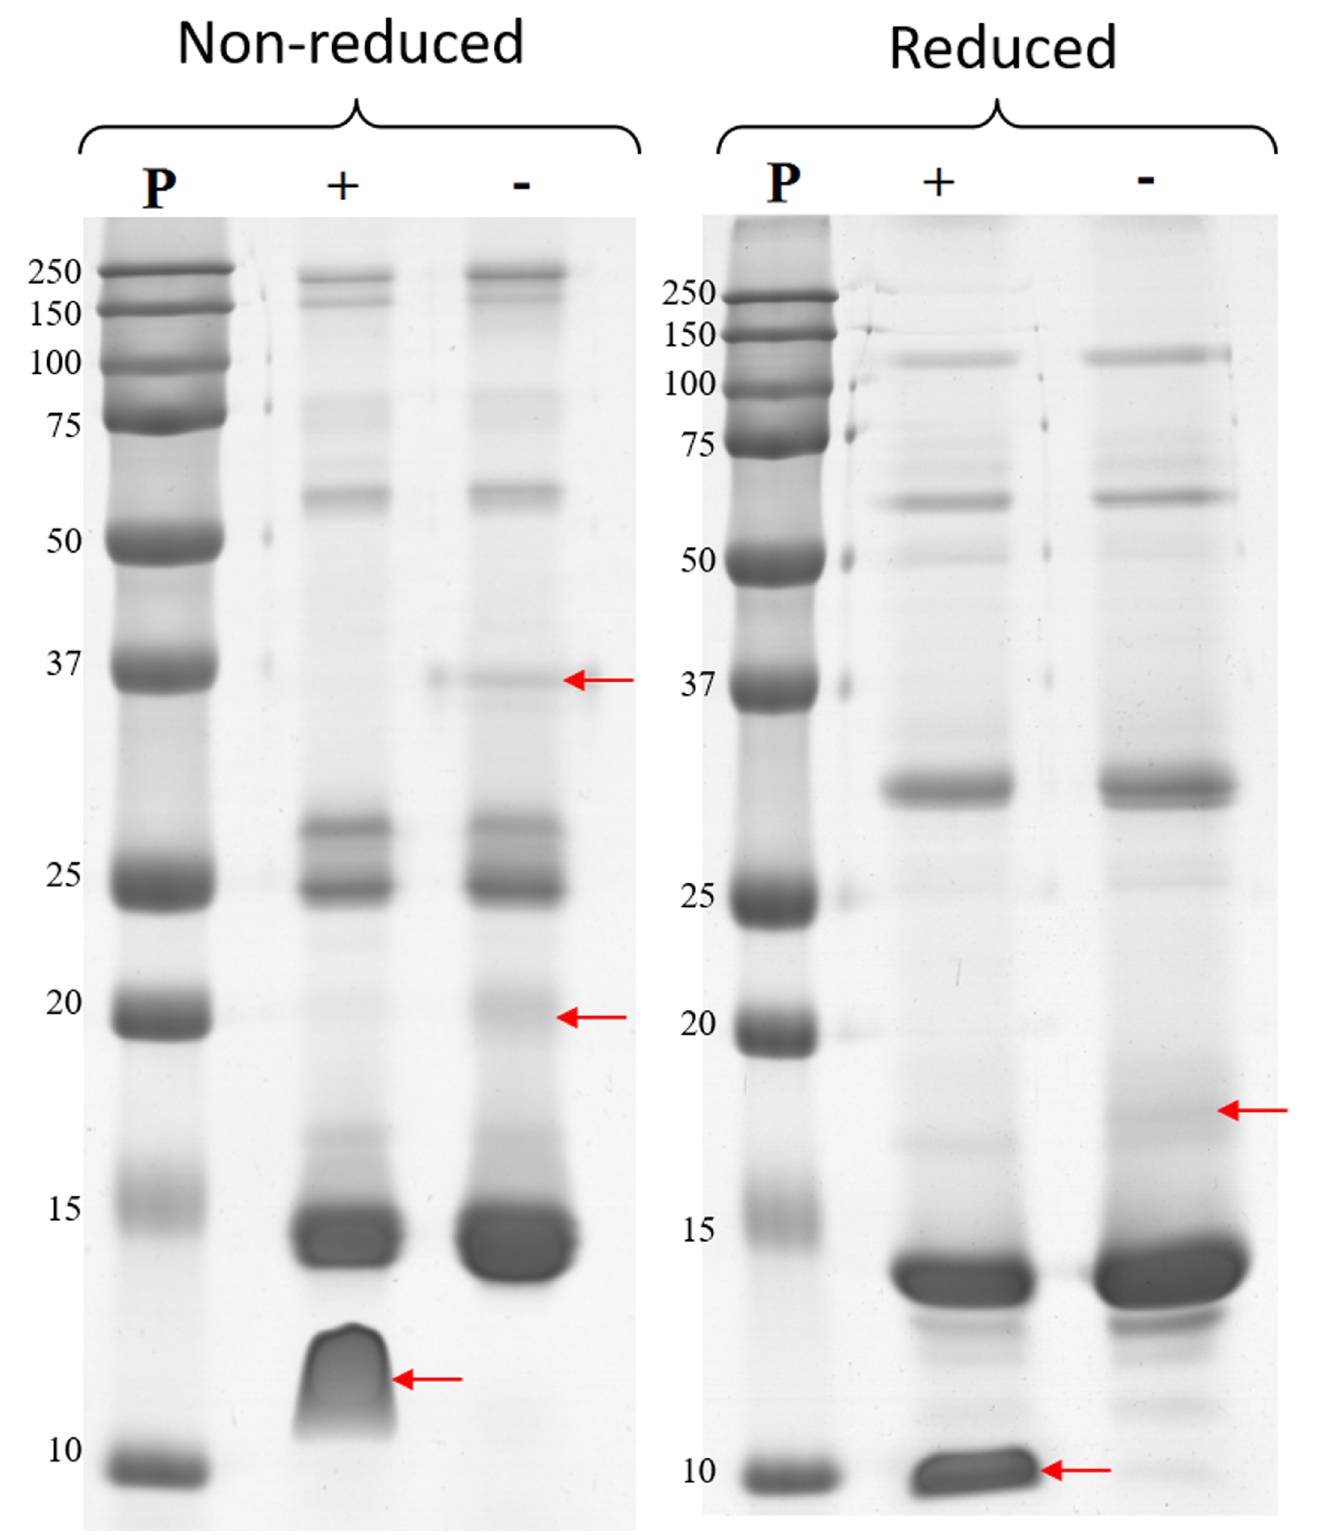
Figure 4. Electrophoretic profile of crotamine-positive pool (+) and crotamine-negative pool (–) from C. durissus venom under reduced (left panel) and non- reduced (right panel) conditions. Venom pools (20 µg) were subjected to 15% SDS-PAGE and proteins were stained using Coomassie G (GE Healthcare). Arrows point to different bands between crotamine-positive and crotamine-negative venom pools. MW: molecular weight marker (Dual Color Precision Plus Protein Standards –